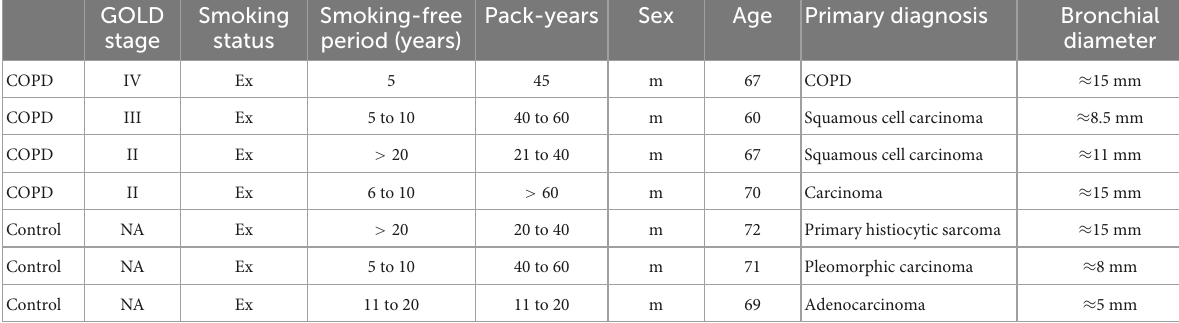
TABLE 1 Patient information and bronchial diameter of specimens used for cell isolation. GOLD